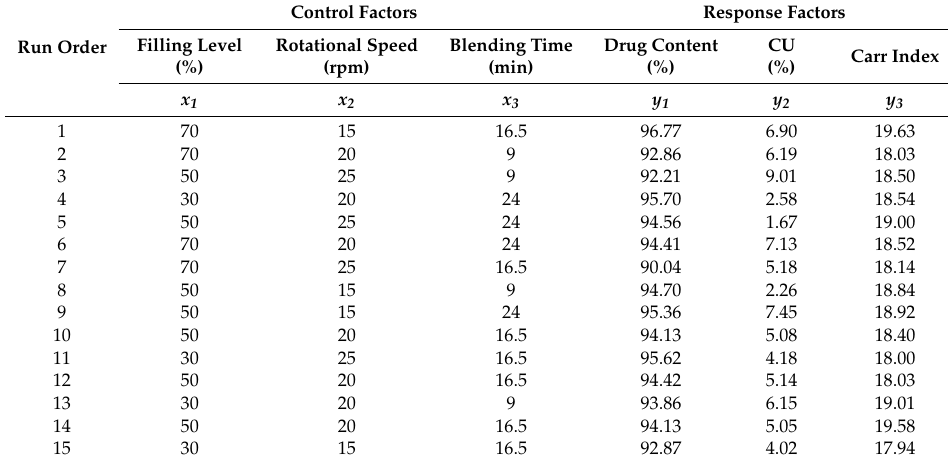
Table 3. DoE (design of experiments) of blending process parameters with three control factors, and values of response factor for each run order.